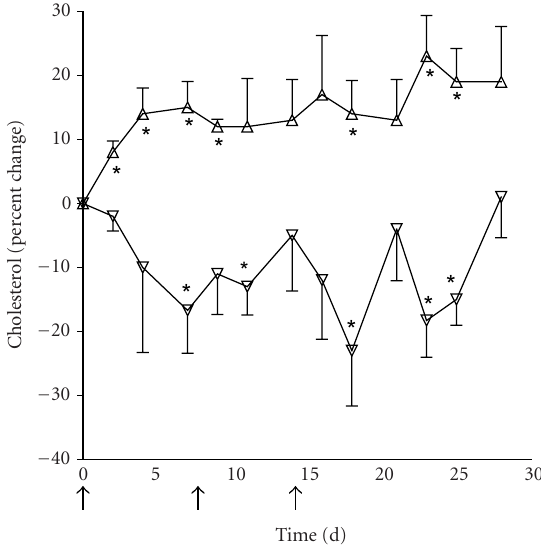
Figure 2. Average percent change in plasma HDL ( ∆ ) and VLDL + LDL ( ∇ ) cholesterol concentrations in cynomolgus mon- keys after a single injection of the truncated apoC-I peptide at 20 mg/kg on day 0 (arrow). Monkeys were fed the HCHF diet. Values are expressed as mean ± SE, n = 2. Values significantly di ff erent from those at day 0 are marked by an asterisk ( P < . 05).